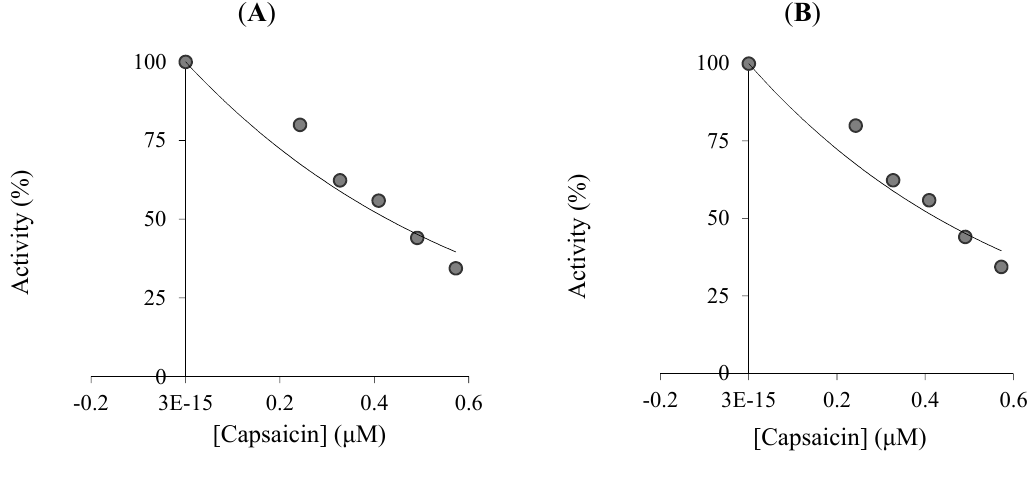
Figure 3. The effects of different concentrations of capsaicin on human erythrocyte carbonic anhydrase I ( A ), and II ( B ) isoenzymes (hCA I, and